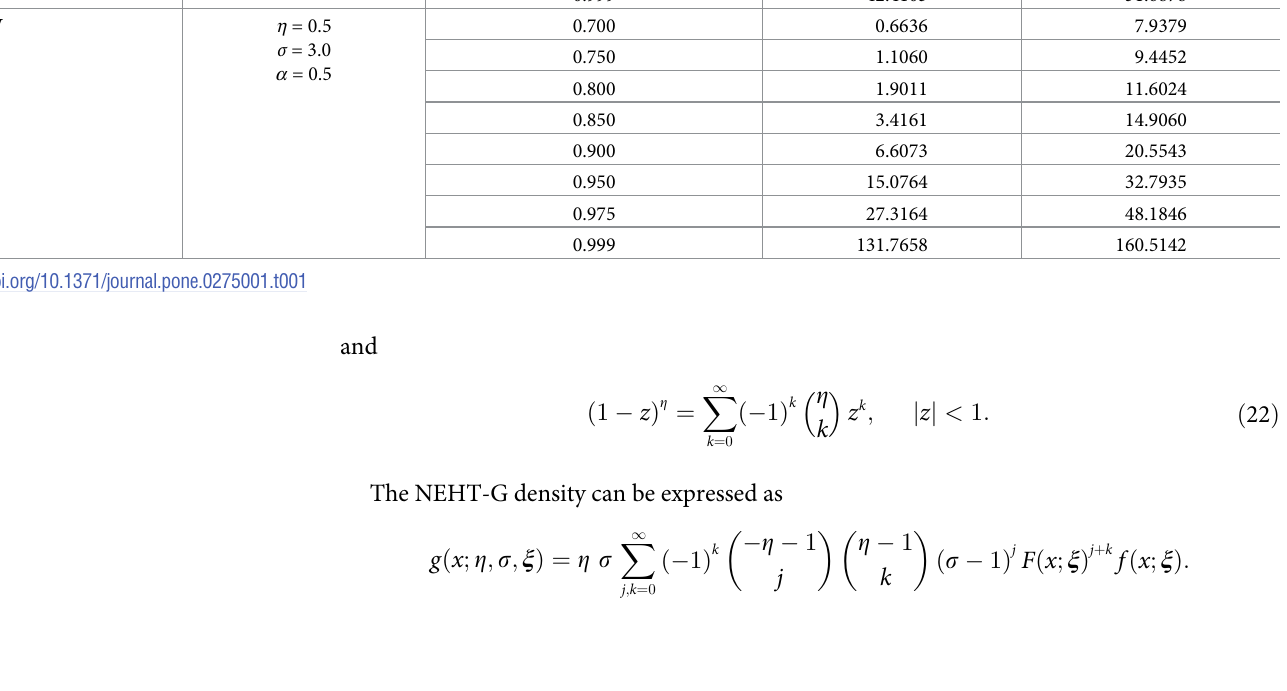
Table 2. Simulated values of the VaR and TVaR at different significance levels for n = 100.